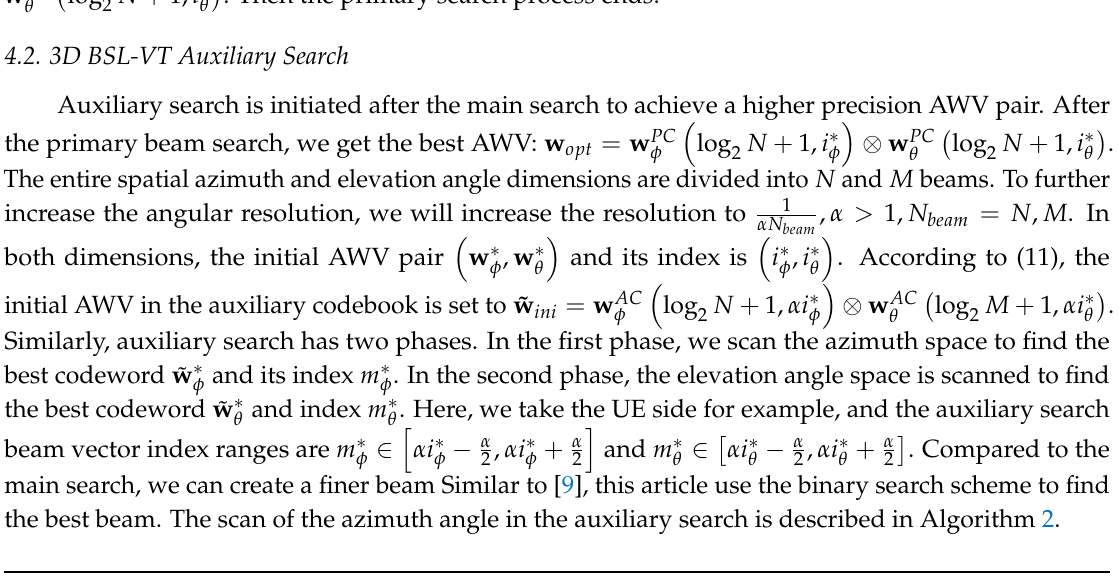
Algorithm 2: 3D BSL-VT auxiliary search for φ